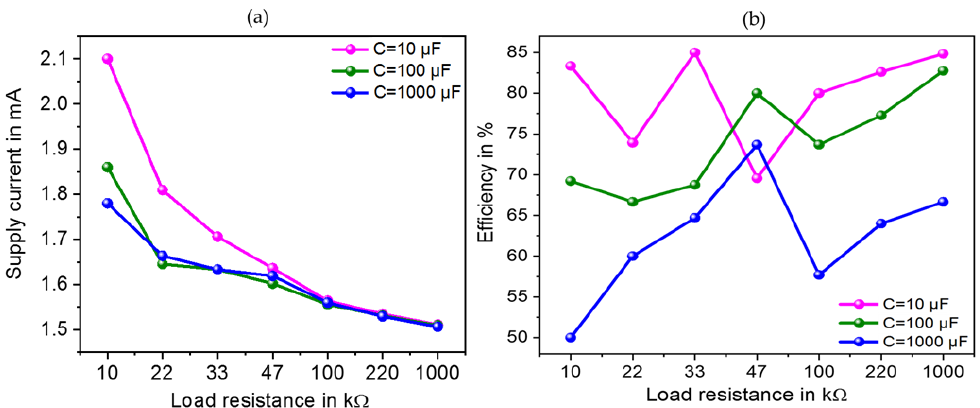
Figure 14. Current supplied by piezoelectric device and the output efficiency versus load resistance through different load capacitors ( a , b ).